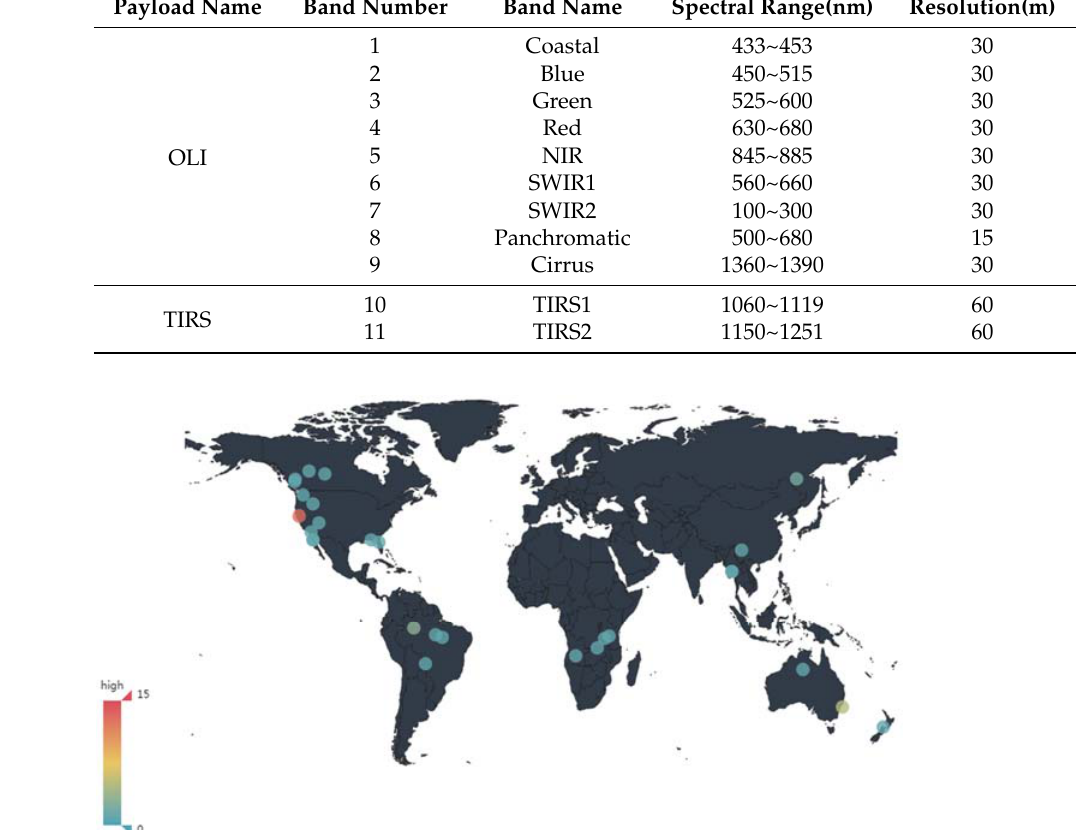
Figure 1. Spatial distribution of study regions in the datasets.